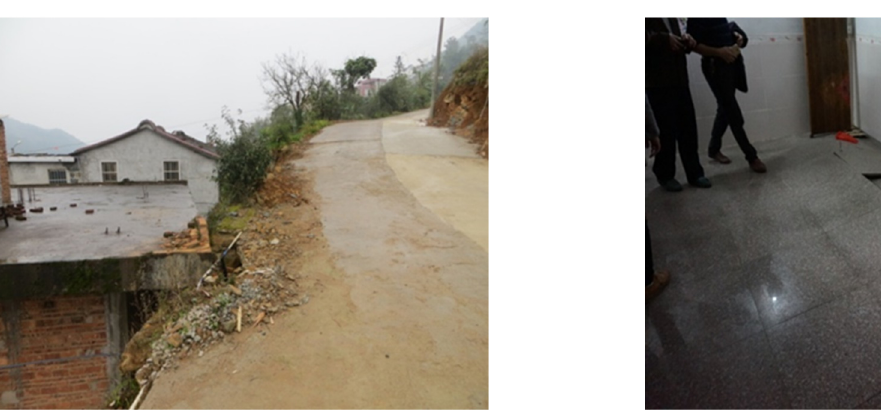
Figure 2. Road cracks.